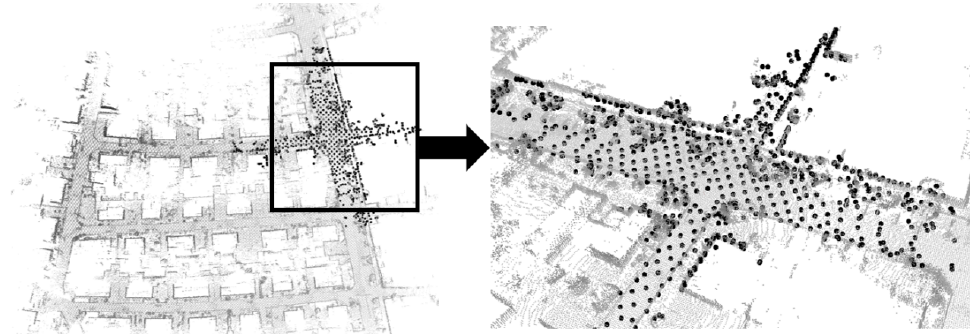
Figure 6. Local magnification during NDT relocation in KITTI